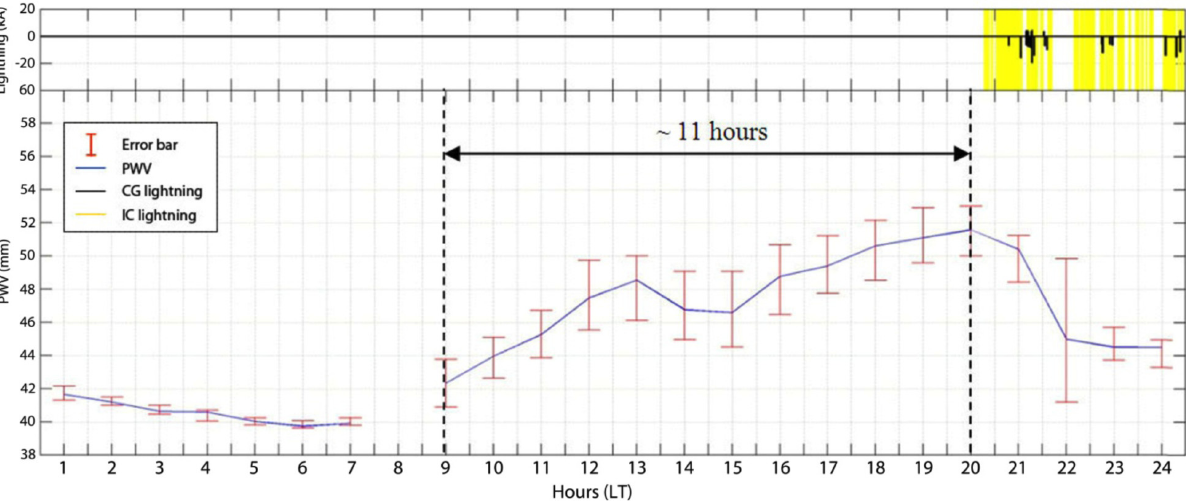
Figure 10. The variation of PWV during heavy lightning on May 1st, 2009, for KRAI station. The top panel of the figure showed the light- ning activity and the bottom showed the PWV variation together with error bar graph.